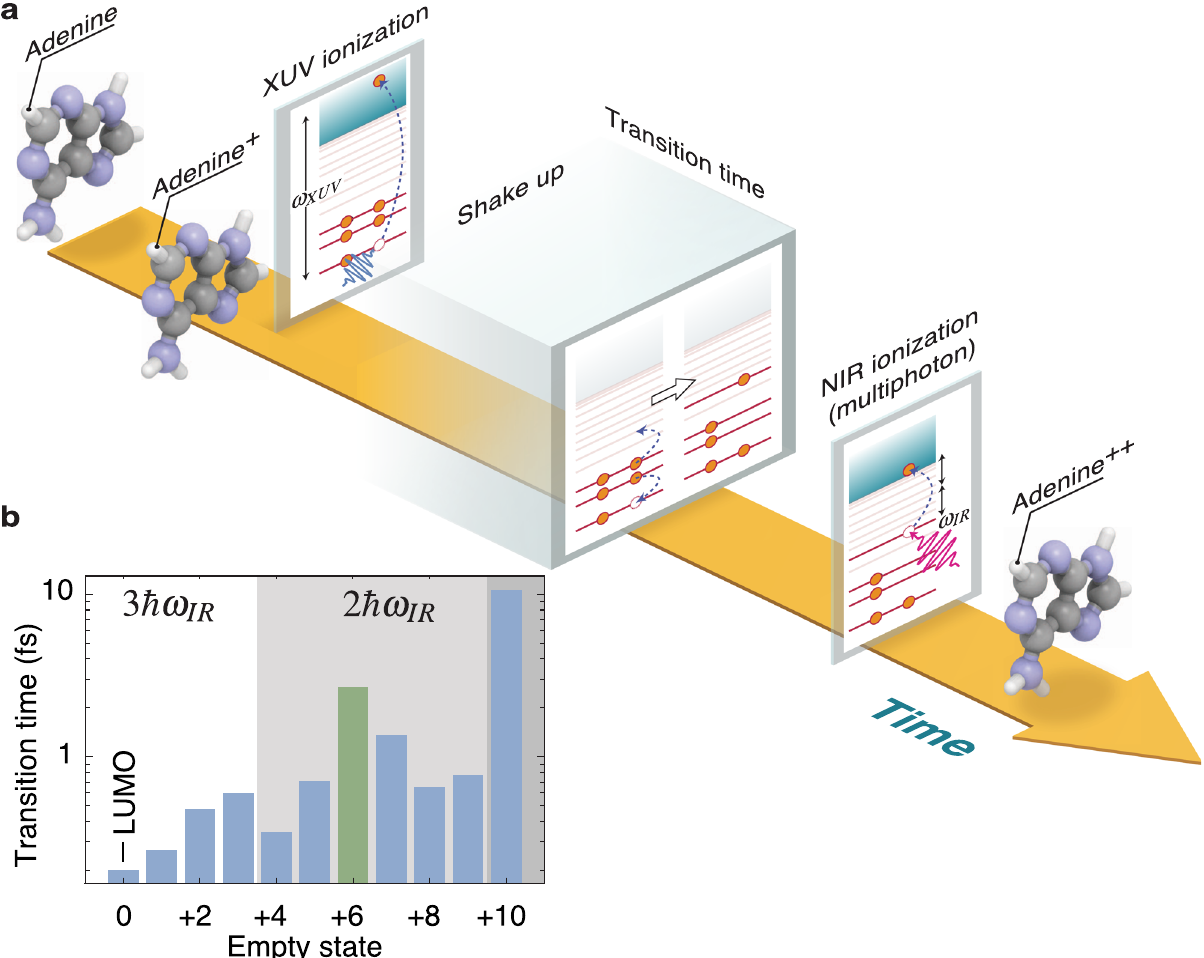
Fig. 2 Overview of the molecular dynamics: the shake-up process. a Following XUV photoionisation, a hole is created in the inner valence. The hole decays in a characteristic transition time and, due to electronic correlations, this can lead to excitation of a second electron to a bound excited state, called shake-up state. If optimally time-delayed from the XUV, the NIR control pulse extracts the excited electron, hence doubly ionising the molecule. b Transition times to a given shake-up state calculated with a Fermi ’ s Golden rule approach. A special shake-up state (LUMO + 6) is highlighted in green and shows a characteristic time of 2.5 fs. The states are ordered by energy and grouped (shades of grey) by the number of NIR photons (1, 2 or 3) required to ionise a second electron. The LUMO + 6 state falls in the two NIR-photon